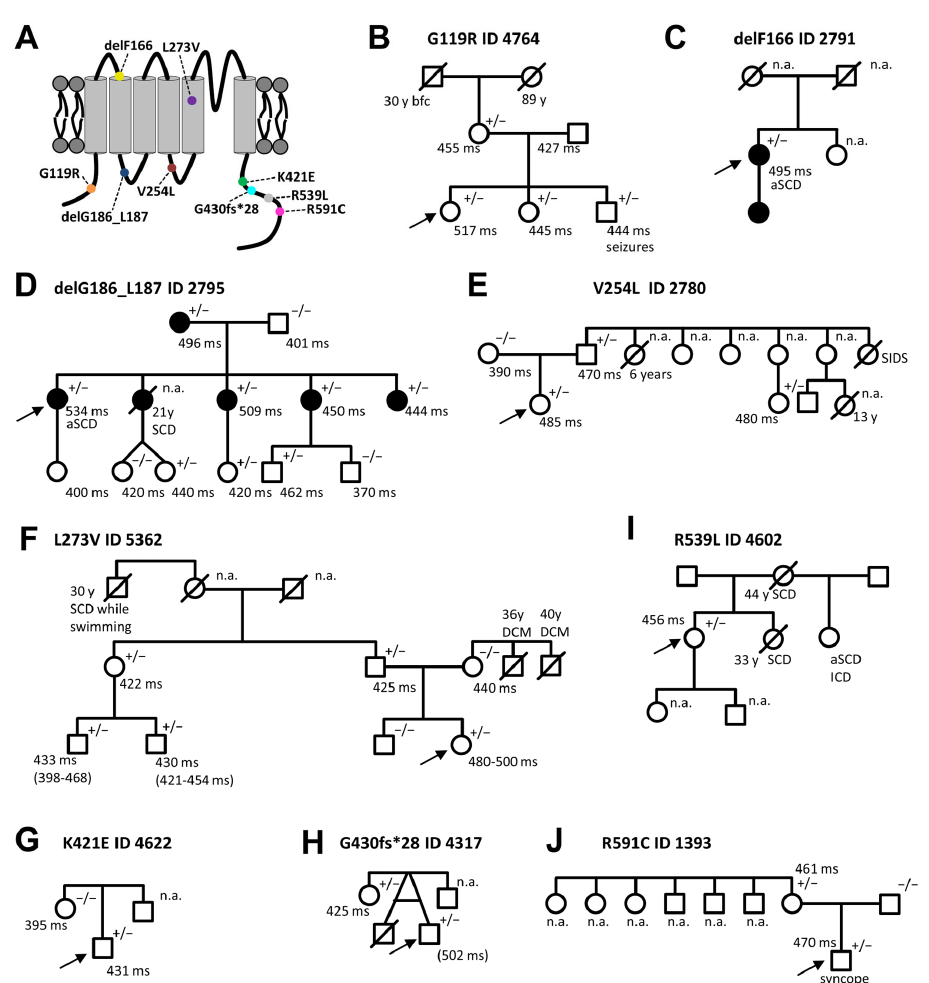
Figure 1. Localization of the identified KCNQ1 variants in the KCNQ1 channel and pedigrees of the respective LQT1 index patients. ( A ) Topology of the KCNQ1 channel α -subunit with the localization of the variants highlighted by colored circles. ( B ) Pedigree of the index patient 4764, harboring the KCNQ1 variant G119R; ( C ) of the index patient 2791, harboring the KCNQ1 variant delF166; ( D ) of the index patient 2795, with the KCNQ1 variant delG186_L187; ( E ) of the index patient 2780, harboring the KCNQ1 variant V254L; ( F ) of the index patient 5362, with the KCNQ1 variant L273V; ( G ) of the index patient 4622, harboring the KCNQ1 variant K421E; ( H ) of the index patient 4317, with the KCNQ1 variant G430fs*28 (the QTc time of the index patient is provided in parenthesis, since a QTc prolongation occurred only once and temporarily); ( I ) of the index patient 4602 with the KCNQ1 variant R539L; and ( J ) of the index patient 1393, with the KCNQ1 variant R591C. Index patients are marked by arrows. Filled symbols indicate patients and family members with a previous diagnosis of LQTS with or without symptoms. Squares and circles represent male and female subjects, respectively. In the top right of the symbol, genetic information is given: +/ − , heterozygous variant carrier and − / − , no variant carrier; not available (n.a.). Below the symbols, QTc time is and information about certain symptomatic or further diseases are given. SCD, sudden cardiac death; bfc, battlefield casualty; DCM, dilated cardiomyopathy; aSCA, aborted sudden cardiac death; SCD, sudden cardiac death; and SIDS, sudden infant death syndrome. Symbols with a line mark through them are deceased subjects, and the age (y) and cause of death are